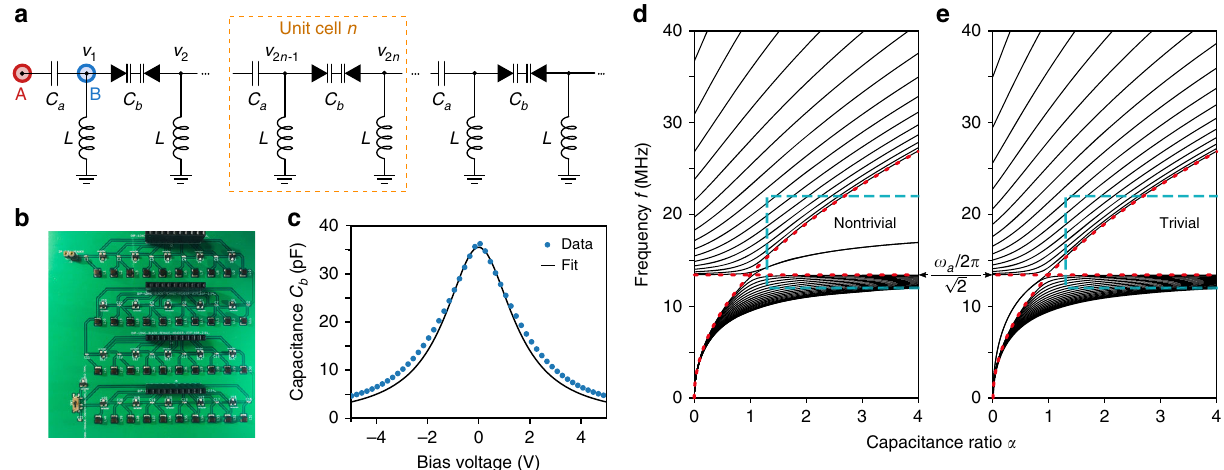
Fig. 1 Design and implementation of SSH-like left-handed transmission line. a Schematic of the transmission line circuit with alternating capacitances: linear capacitors with capacitance C a , and back-to-back varactors with nonlinear capacitance C b . The capacitances act like hoppings in a nonlinear Su – Schrieffer – Heeger (SSH) model. An input voltage is applied at points A or B to probe the topologically trivial or nontrivial lattice. b Photograph of the printed circuit board. c Capacitance C b versus bias voltage. Dots are calculated from varactor manufacturer data, and the solid curve is the fi t based on Eq. (5). d , e Calculated eigenfrequencies of a fi nite closed linear circuit, versus the capacitance ratio α = C a / C b . The characteristic frequency is f a = ω π ≈ 19 MHz, and the lattice has 40 sites. Two cases are shown: d C a /2 e C b -type capacitors at the edge, for which the α > 1 gap is trivial. Red dotted curves indicate the band-edge frequencies f a = indicate the operating regime of the nonlinear circuit, with α ≈ 1.3 in the linear (low-voltage) limit and α effectively increasing with voltage